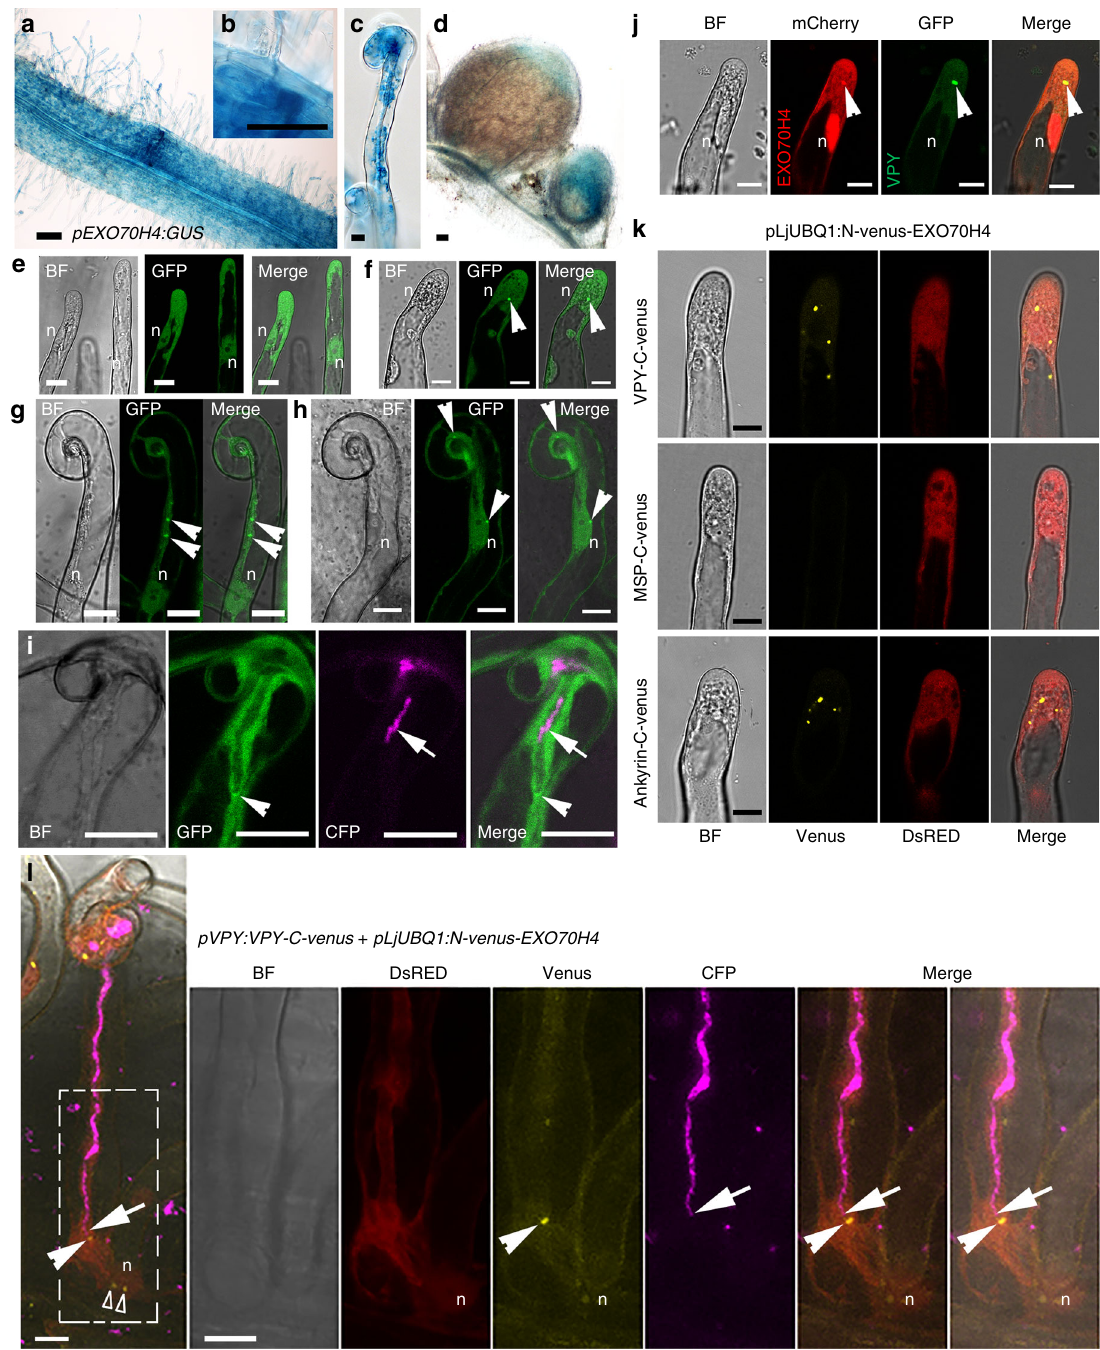
Fig. 9 EXO70H4 co-localizes with VPY. a – d Expression of EXO70H4 in roots inoculated by rhizobia ( a ), at a rhizobial infection site ( b ), in a root hair containing an infection thread ( c ) and in nodules ( d ) as shown by pEXO70H4:GUS activity. e Subcellular localization of GFP-EXO70H4 in root hairs without inoculation with rhizobia. f – i Subcellular localization of GFP-EXO70H4 in root hairs following inoculation with Rm1021-CFP (magenta). j Co-localization of VPY-GFP (green) and mCherry-EXO70H4 (red) at the same punctus in root hairs of rhizobia-inoculated composite plants transformed with pVPY:VPY-GFP / pLjUBQ1:mCherry-EXO70H4 . k Bimolecular Fluorescence Complementation (BiFC) experiments in root hairs following inoculation with rhizobia. Split Venus fl uorescent protein was used, with N-Venus fused to EXO70H4 driven by pLjUBQ1 promoter and C-Venus fused to VPY, MSP domain or ankyrin repeats containing domain of VPY driven by VPY promoter. l Live cell confocal images showing a root hair undergoing infection in a sunn-2 composite plant containing pVPY:VPY-C-Venus , and pLjUBQ1:N-Venus-EXO70H4 . Split Venus fl uorescence was imaged 3d after inoculation with Sm2011-CFP, in a root hair hosting an elongating infection thread. Venus fl uorescence (arrowheads in l ) was associated notably to the tip of a growing infection thread (arrows); Venus fl uorescence (open arrowheads) was also found associated to a number of other puncta in the nucleus vicinity. Five ongoing infection sites where imaged in four plants in l . GUS staining is shown as blue. DsRED was used as a transgenic marker. DsRED, Venus, GFP and CFP were given pseudo coloured in red, yellow, green and magenta respectively. n, nucleus. Arrowheads, GFP/mCherry /Venus puncta. Arrows, CFP tagged rhizobia. Scale bars, 100 µ m ( a , d ) and 10 µ m ( b , c , e – l